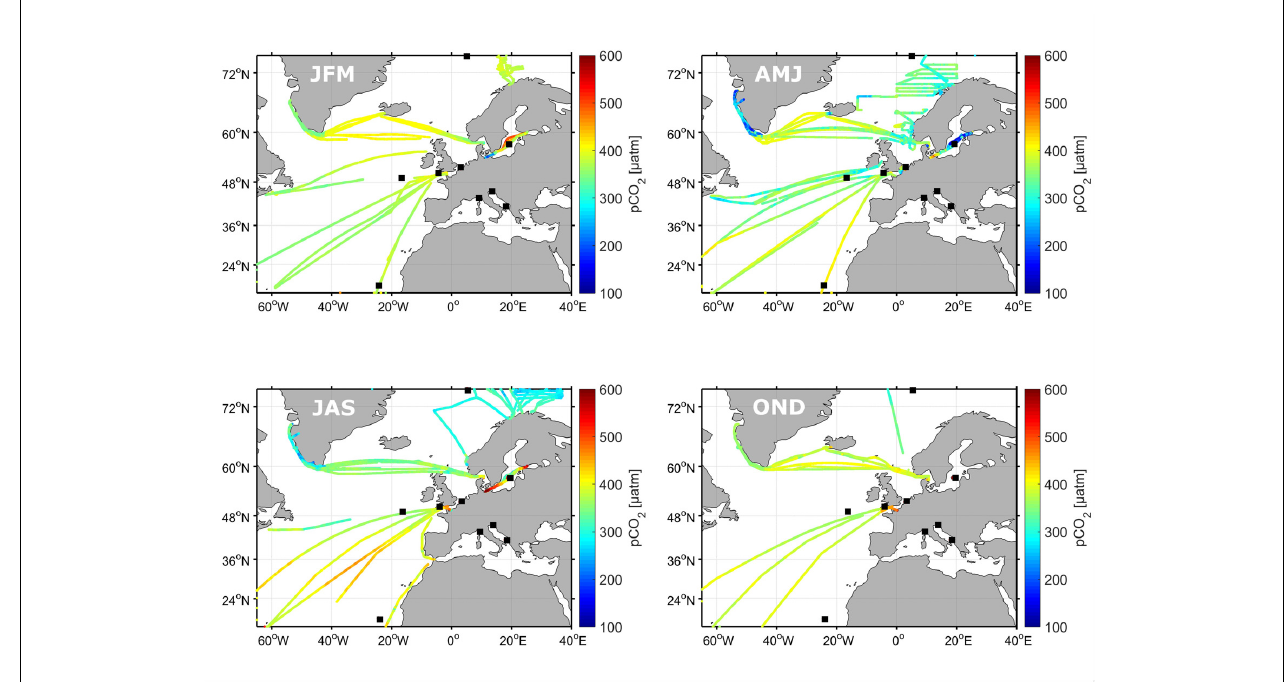
FIGURE 4 | Seasonal p CO 2 (e.g., JFM: January, February, March) data generated by the ICOS SOOP network in the year 2017 (data can be downloaded at www.socat.info). The FOS are shown as black